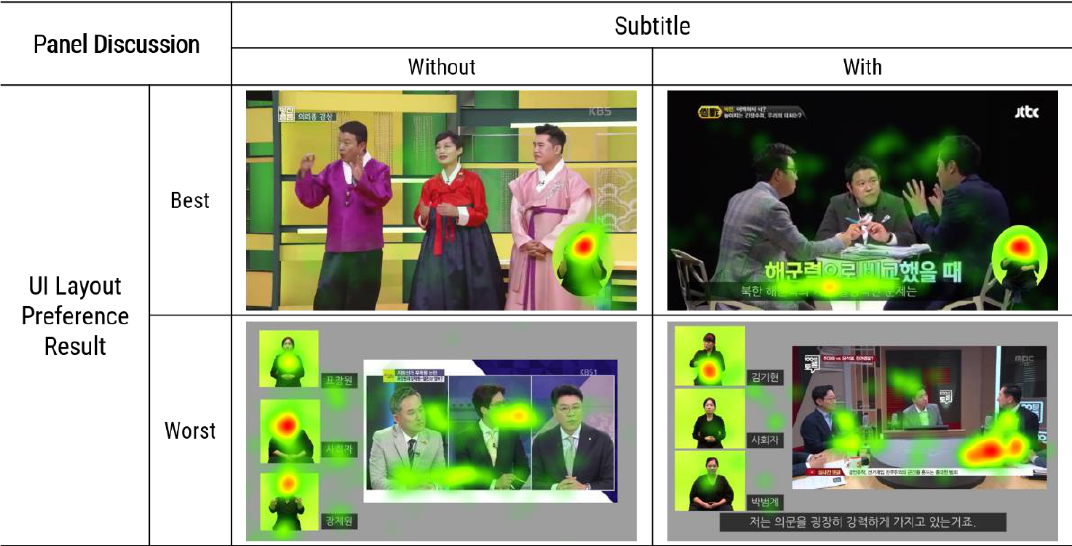
Figure 15. Results of eye tracker experiments with discussion cases.